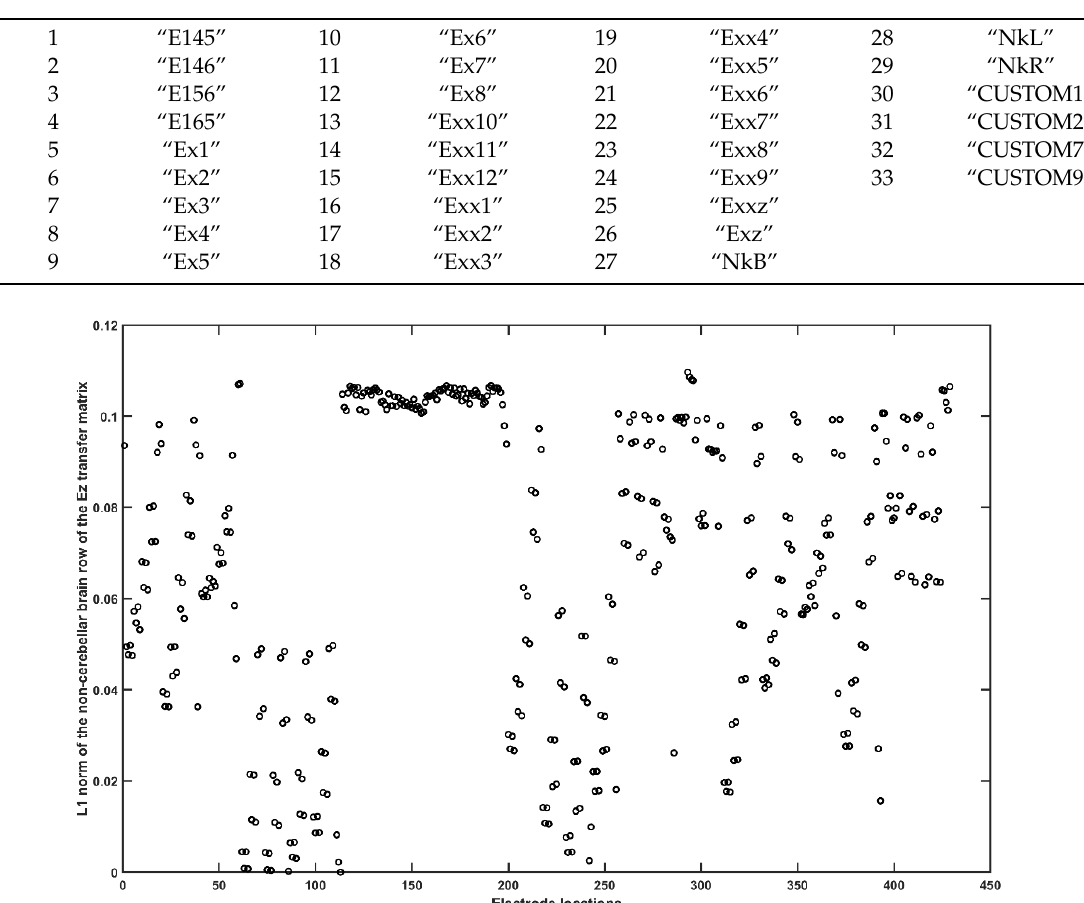
Figure A10. L1 norm of the non-cerebellar brain row ( = 35) of the Ez transfer Figure A10 . L1 norm of the non − cerebellar brain row (= 35) of the Ez transfer matrix.